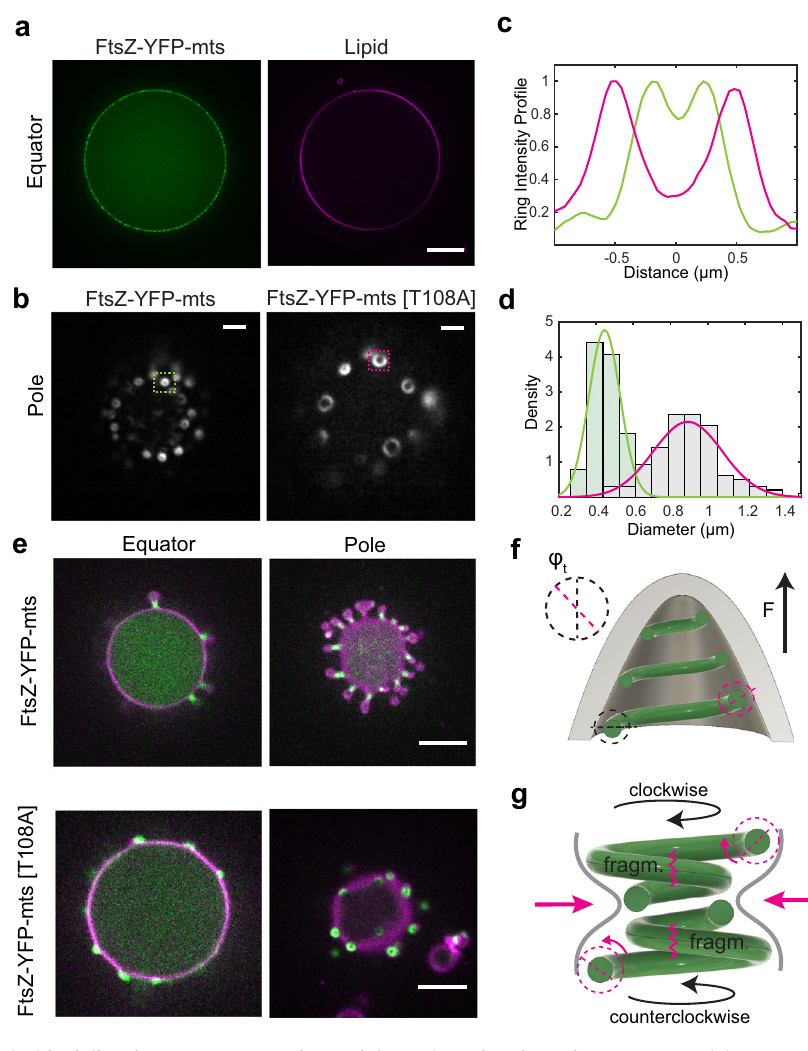
clockwise fragm. fragm . counterclockwise Fig. 5 FtsZ-YFP-mts rings inside de fl ated GUVs cause membrane deformations that depend on GTPase activity. a Representative image of GUVs encapsulating FtsZ ( N > 10, each condition) (scale bar = 5 µ m). b TIRF microscopy imaging of FtsZ-YFP-mts and FtsZ-YFP-mts*[T108A] rings at the bottom-inside GUVs ( N > 10, each condition) (scale bar = 2 µ m). c Intensity pro fi le of structures indicated in b showed that FtsZ-YFP-mts (green line) rings exhibit smaller diameter than FtsZ-YFP-mts*[T108A] (magenta line). d Size distribution of ( N = 112) FtsZ-YFP-mts*[T108A] (gray bars and magenta line) and ( N = 102) FtsZ-YFP-mts showed a drastic reduction in ring diameter due to GTP hydrolysis. e After de fl ation, both mutants yielded outwards deformations. For the case of FtsZ-YFP-mts, N = 21/26 (80%) vesicles showed outwards deformations and constriction necks compared to N = 4/15 (26%) for FtsZ-YFP-mts*[T108A]. This suggests that GTPase activity promotes constriction and neck formation (scale bar = 5 µ m). f We suggest that intrinsic torsion can create out-of-plane forces; however, g GTP hydrolysis triggered a super-constricted state favoring higher curvatures. These higher curvatures and membrane deformations cause a mechanical strain on the polymer that promotes fragmentation and then the emergence of clockwise and anticlockwise FtsZ treadmilling fi